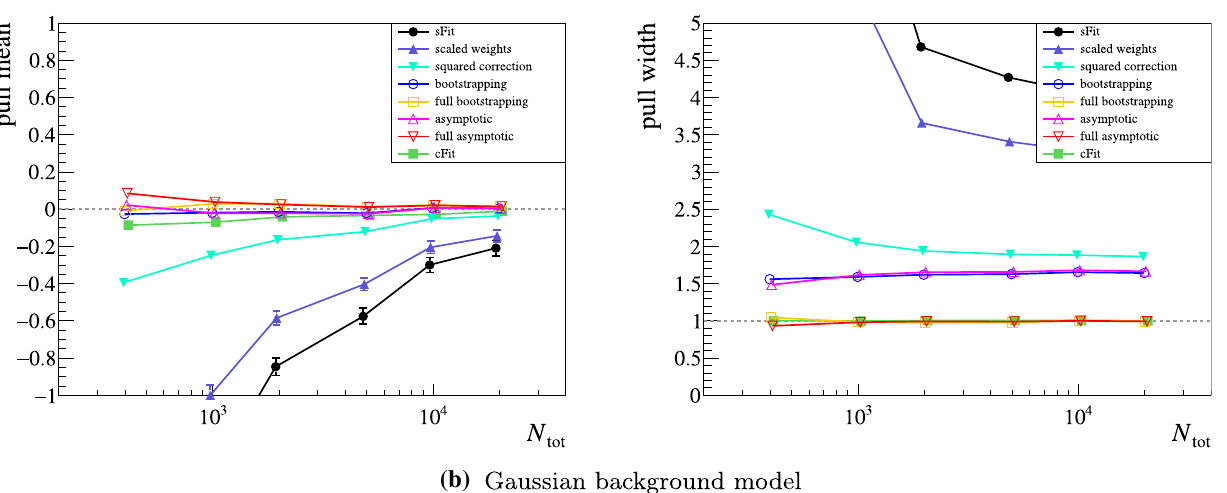
Fig. 10 (Left) Pull means and (right) pull widths depending on total event yield N tot . The markers are slightly horizontally staggered to improve